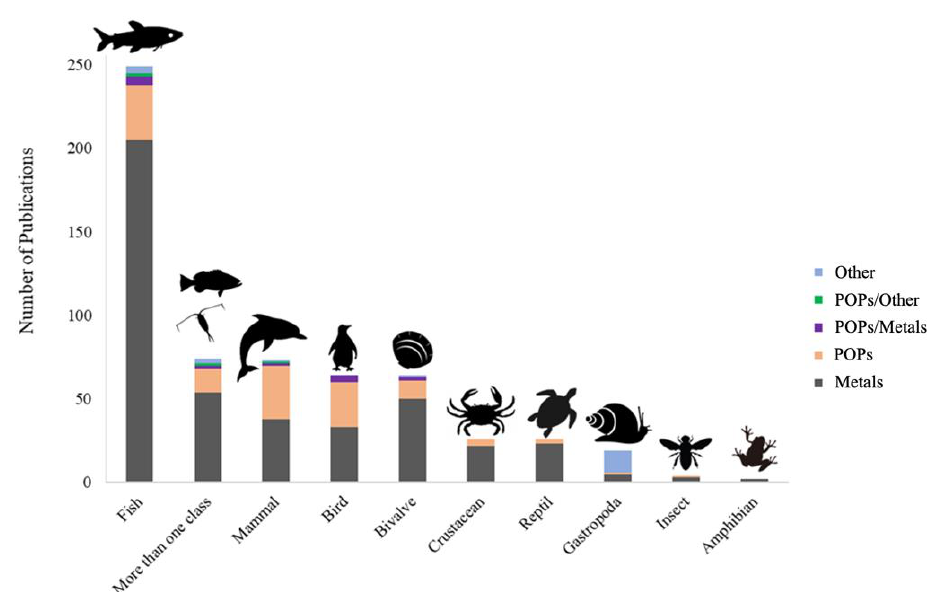
Figure 4. Publications developed by animal group where concentrations of compounds that act as endocrine disruptors were determined. Oligochaeta, Ascidiacea, Chondrichthyes and Polichaeta had one publication each and were excluded from the figure. M (Metals), POPs (Persistent Organic